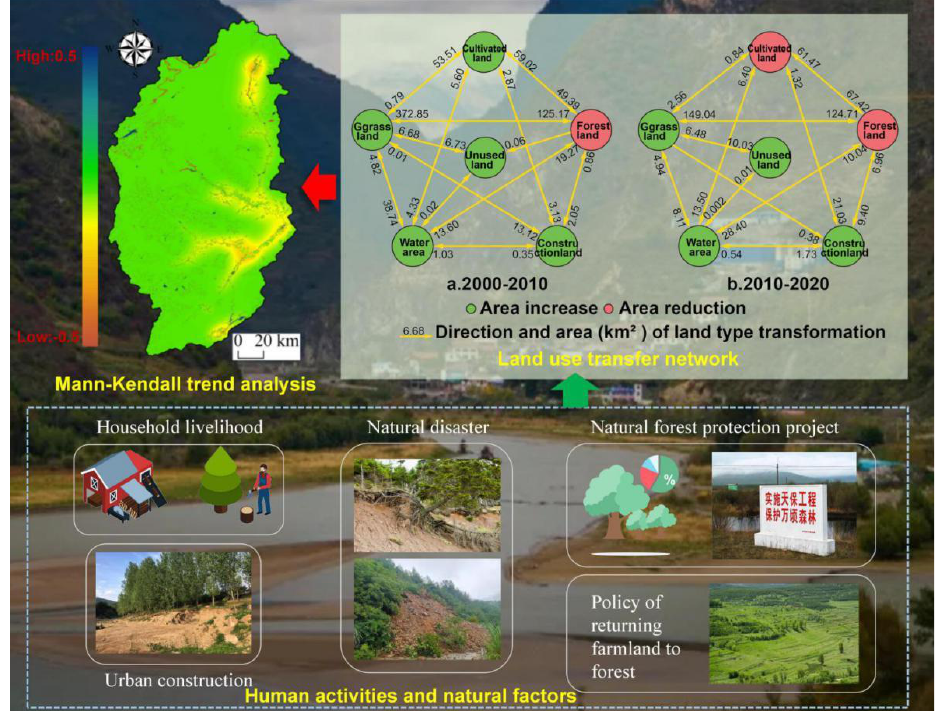
Figure 14. Mechanism behind the topographic gradient effects on habitat quality.